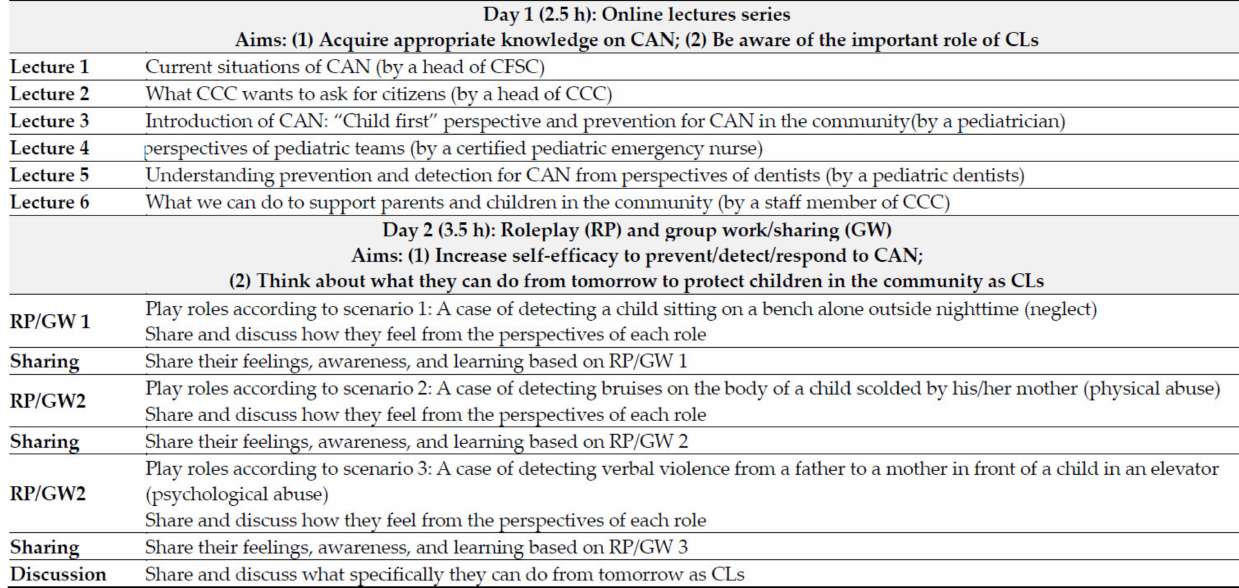
Figure 1. Training program on Child Abuse Prevention for Citizens (TCAP-C). CAN = Child Abuse and Neglect; CFSC = Children Family Support Center; CCC = Children Counseling Cen- ter; CL = Citizen